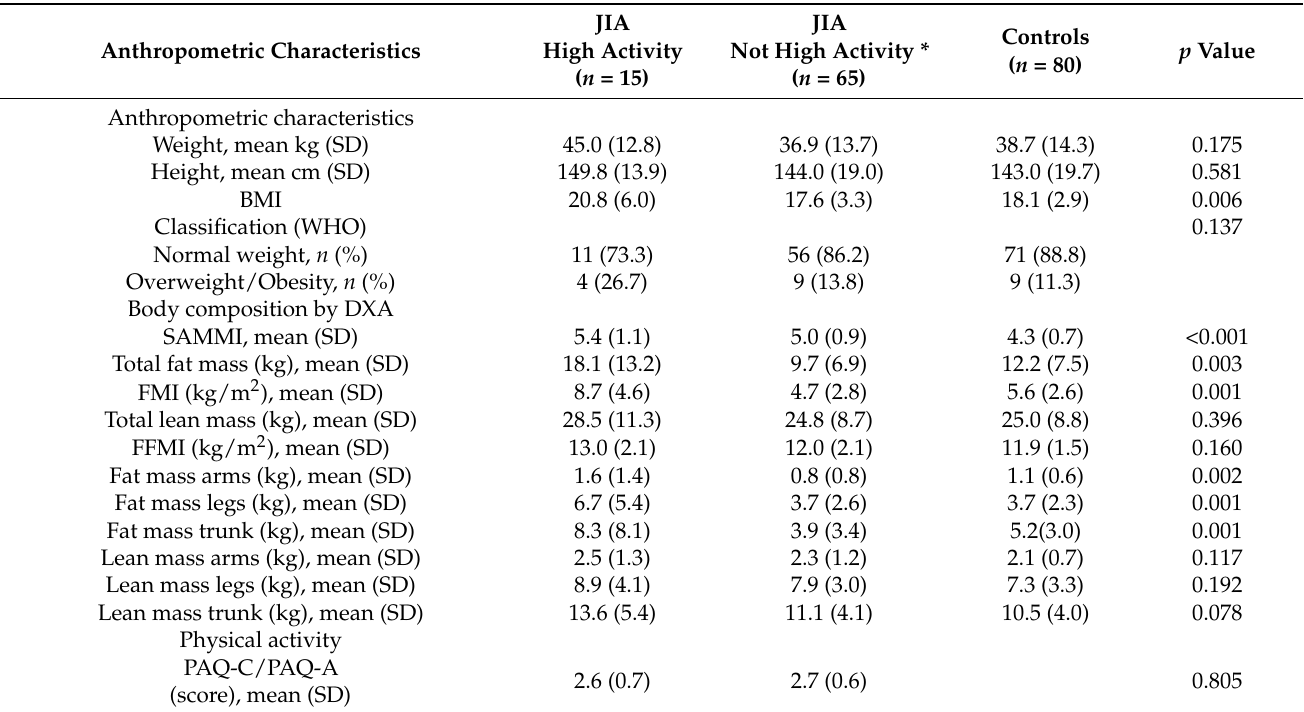
Table 2. Anthropometric characteristics and body composition of patients with JIA and high and low disease activity according to JADAS27 vs. controls on the reference